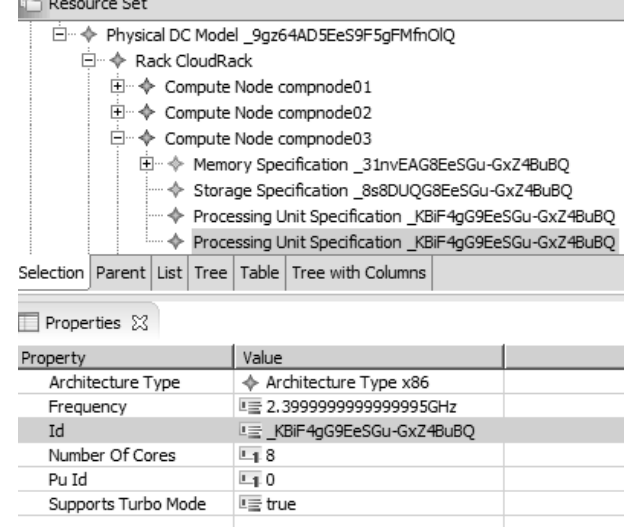
Figure 6. CactoScale created PDCM